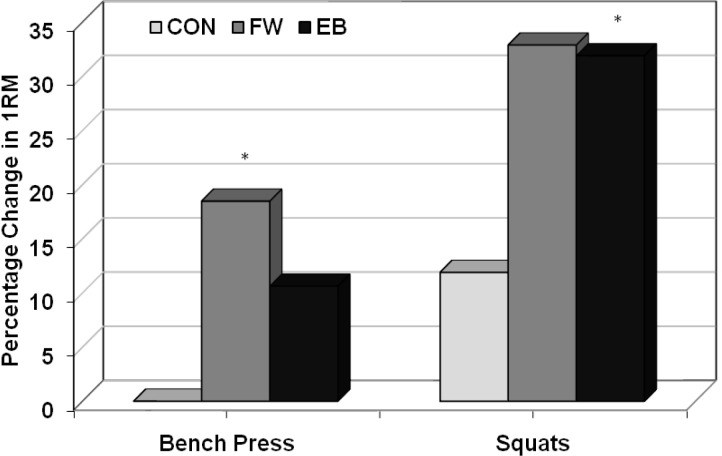
Values are presented as the integrated peak torque values encompassing all speeds at baseline, 12 and 24 weeks. * denotes statistically different from CON (p < 0.05). (Here, the single asterisk (*) denotes EB different from CON as well as FW differences from CON.) CON=control group; FW=free weight group; EB=elastic band and free weight combined training group